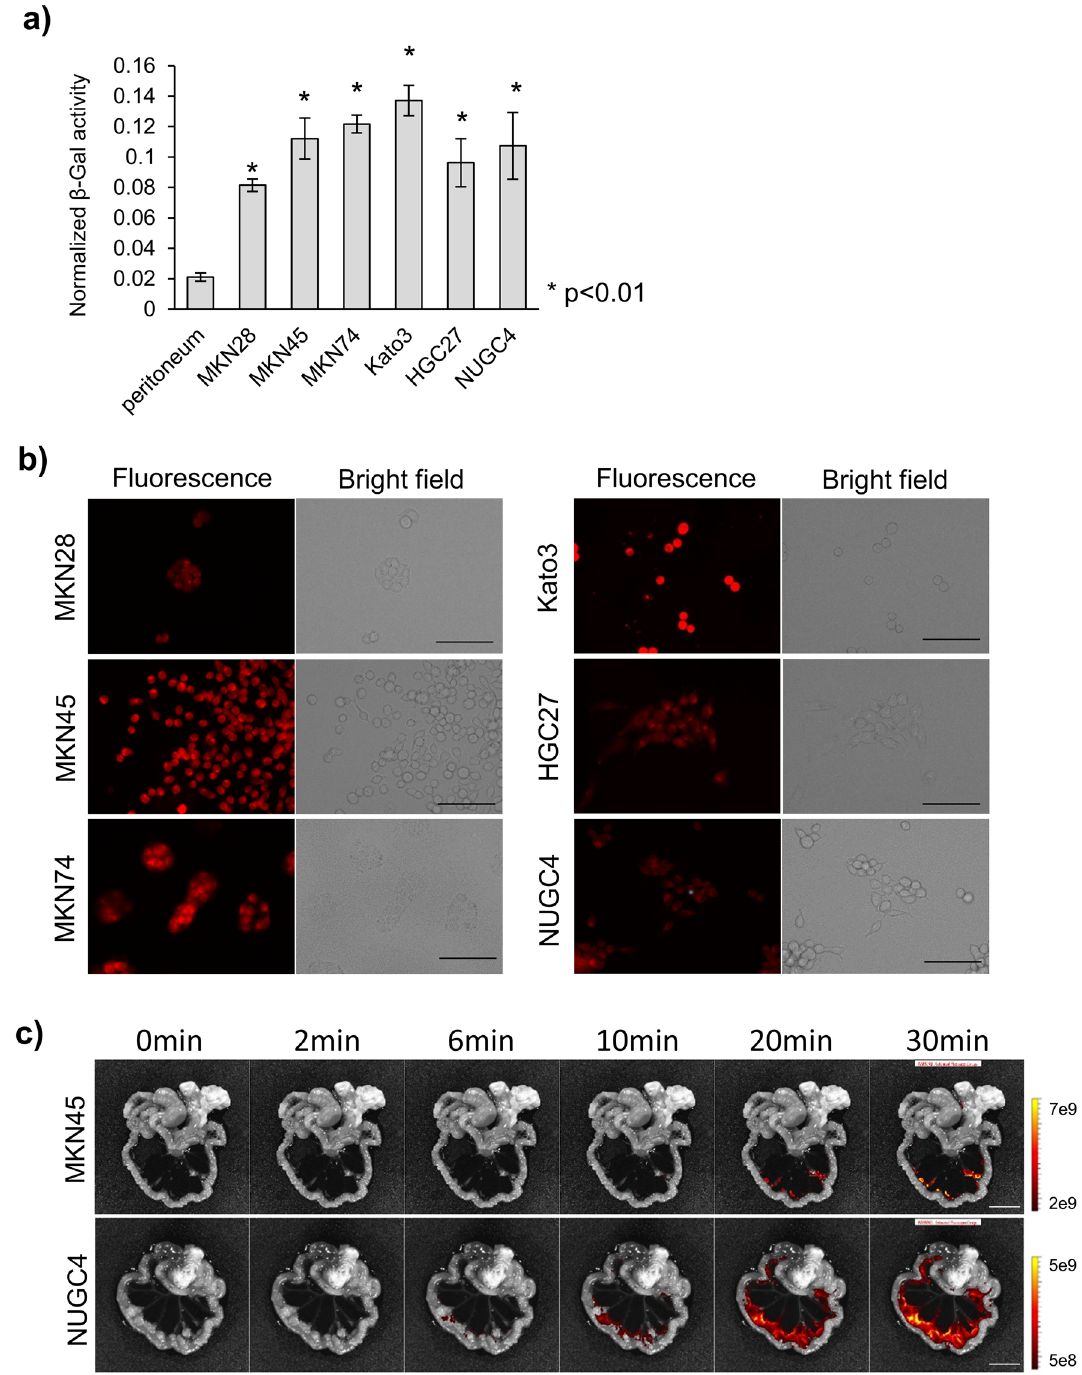
Figure 2. GC cell line analyses. ( a ) β-Gal activity of the GC cell line lysates and mouse NP. ( b ) Live cell imaging of GC cell lines. Scale bar, 100 μm. ( c ) Ex vivo imaging of the mouse model of peritoneal metastasis. Scale bar, 10 mm. β-Gal, β-galactosidase; GC, gastric cancer; NP, normal